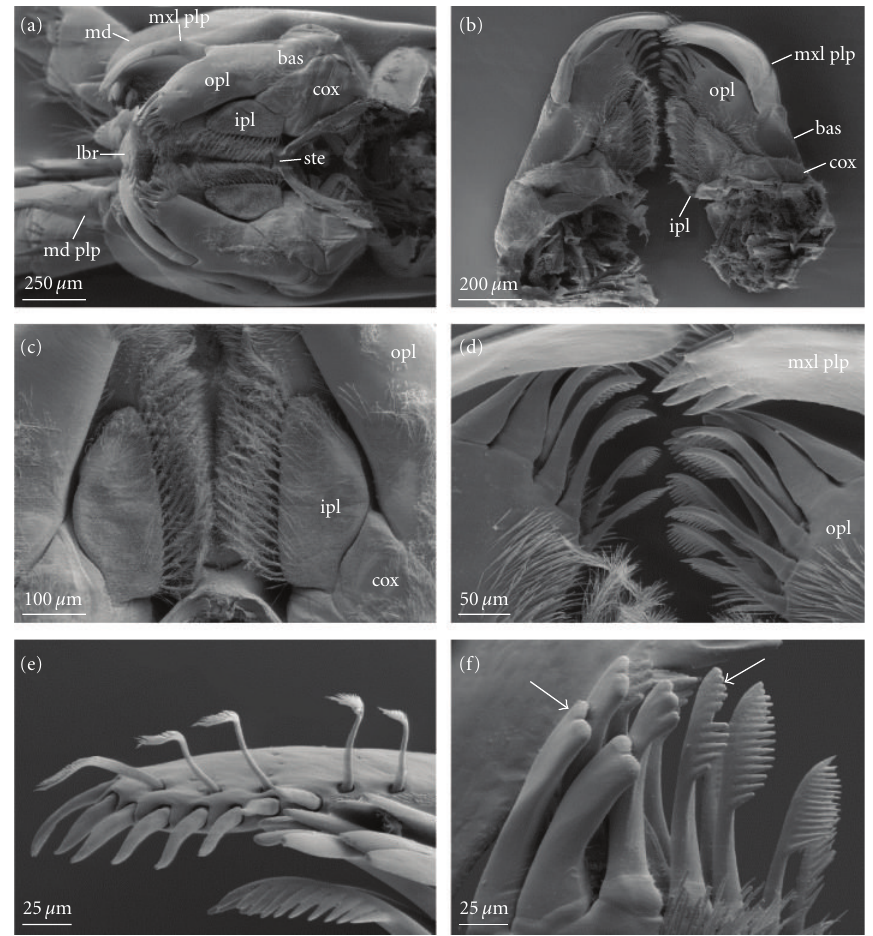
Figure 13: SEM images of maxillulae of Echinogammarus berilloni : (a) maxillulae in situ in posterior view; (b) maxillulae in anterior view; (c) inner plates of maxillulae in situ in posterior view; (d) distal setation of outer plates and palps of maxillulae in anterior view; (e) distal part of palp of left maxillula in medio-posterior view; (f) distal setation of outer plate of right maxillula in posterior view. Arrows indicate signs of